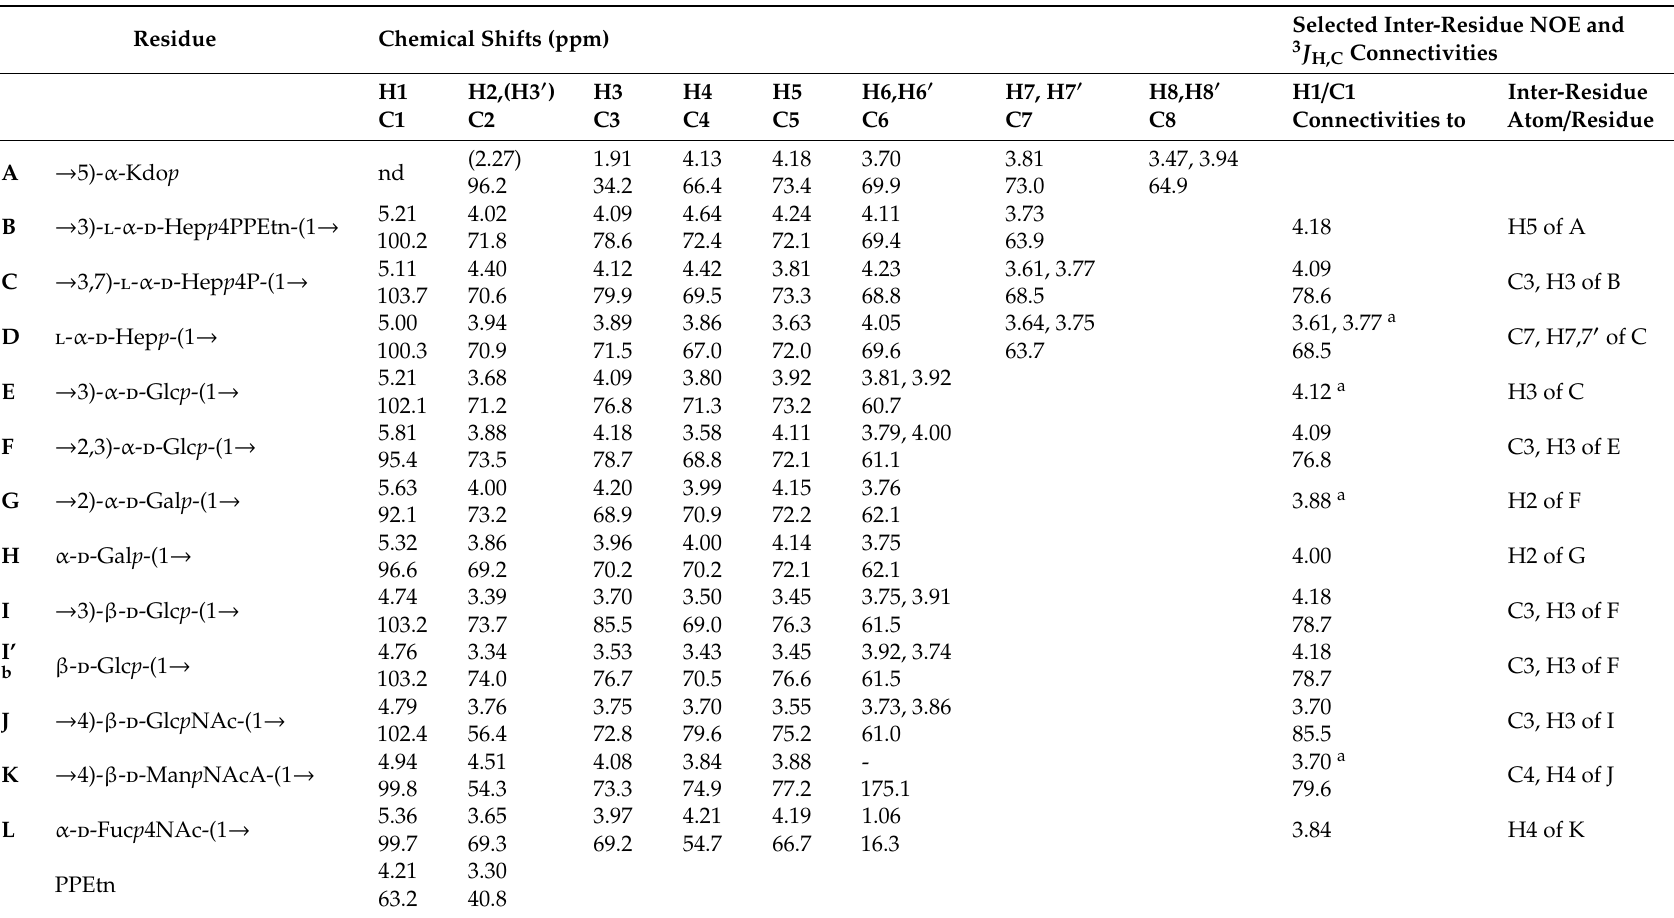
Table 2. The 1 H and 13 C NMR chemical shifts and selected inter-residue correlations from NOESY and HMBC spectra of [ECA]-core glycoform isolated from E. coli R1.